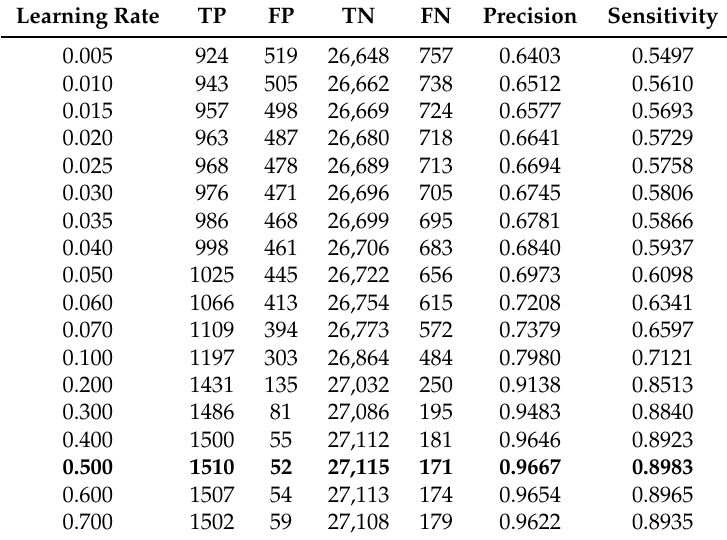
Table 1. Selection of learning rate.